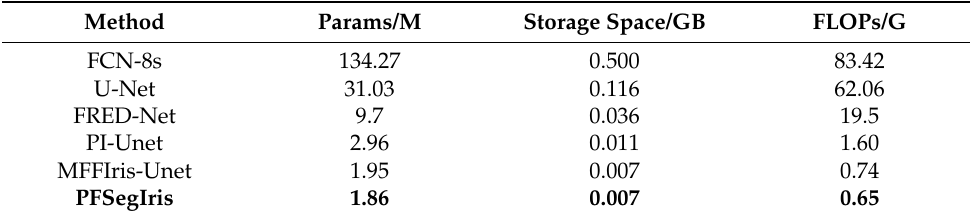
Table 6. Comparison of different algorithms in terms of Params, Storage Space, and